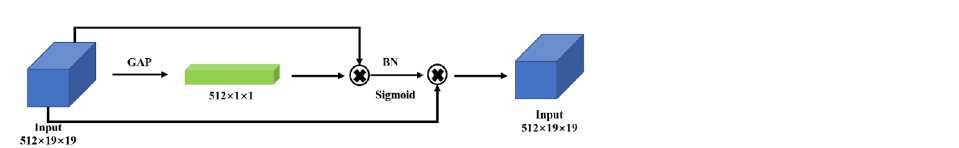
Figure 6. DCA module. Only the corresponding weight is applied to the original feature layer, and the size of the feature layer has not changed, so it can be directly transplanted to the YOLOv4-tiny network.